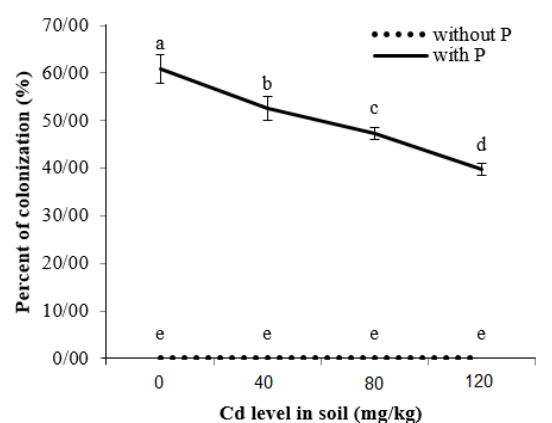
Fig. 1. The effect of different concentration of Cd in soil on root colonization of sunflower: P: P. indica. Values are mean ± SD; n = 5; the same letter indicates no significant difference among treatments using Duncan’s Multiple Range Test at P <